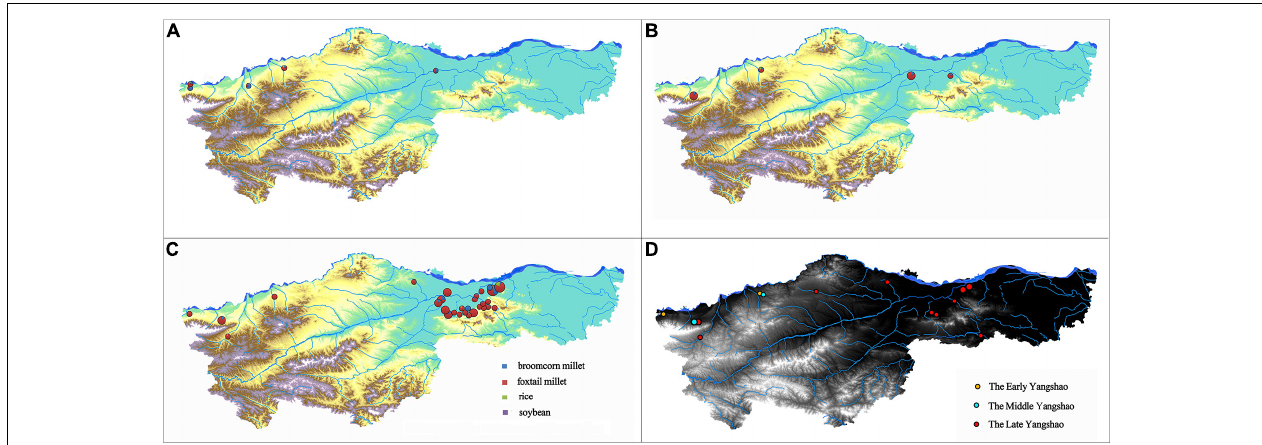
FIGURE 6 | Map of the structure of agricultural systems of the Yangshao Culture (A) Early Yangshao (5000–4200 BC), (B) Middle Yangshao (4200–3500 BC), (C) Late Yangshao (2500–3000 BC), (D) rice distribution through time). Structure of agricultural systems = are represented in pie charts including broomcorn millet, foxtail millet, and rice. Different areas of a site are shown with different circle